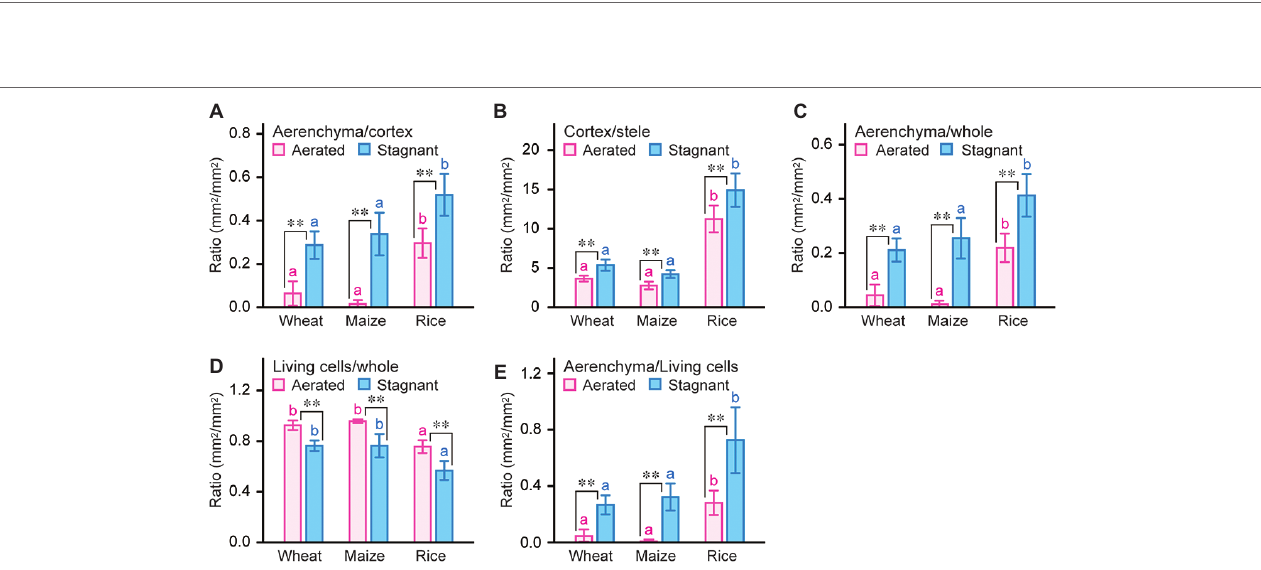
FIGURE 3 | Ratio of each tissue size in adventitious roots of wheat, maize, and rice. Ratio of aerenchyma to cortex (A) , cortex to stele (B) , aerenchyma to whole root (C) , living cells to whole root (D) , and aerenchyma to living cells (E) at 50 mm from the tips of adventitious roots of wheat, maize, and rice under aerated or stagnant conditions. Nine-day-old wheat, maize, and rice seedlings were further grown under aerated or stagnant conditions for 7 days. Significant differences between aerated and stagnant conditions at p < 0.01 (two-sample t -test) are denoted by ∗∗ . Different lowercase letters denote significant differences among different species ( p < 0.05, one-way ANOVA and then Tukey’s test for multiple comparisons). Values are means ± SD ( n =